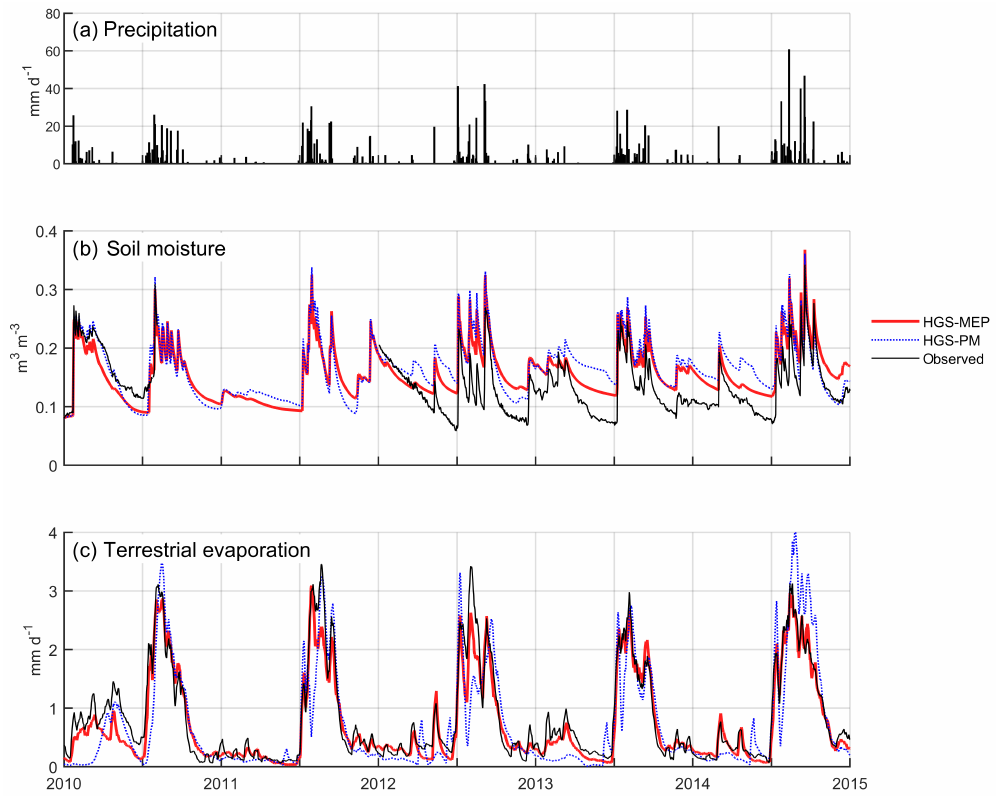
Figure 3. (a) Precipitation as well as observed and modelled (b) daily mean soil water content at a depth of 15cm, and (c) 10d moving average of terrestrial evaporation at US-Wkg (climate: semi-arid; vegetation: grassland).